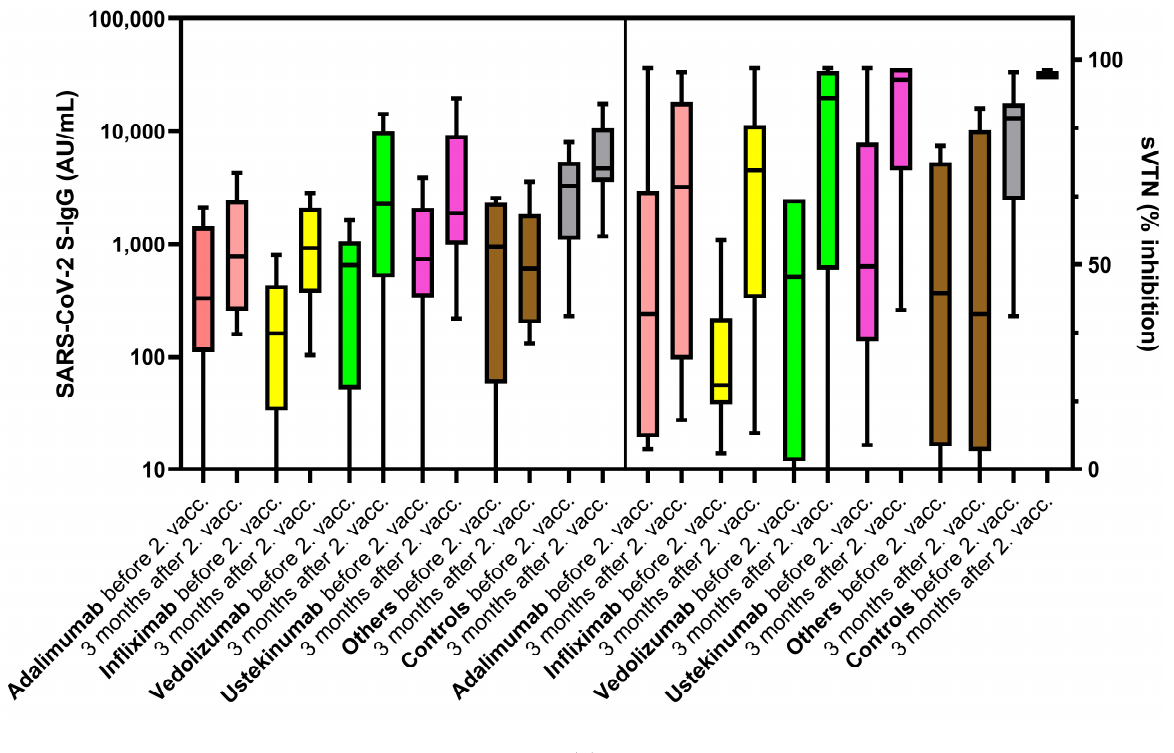
Figure 2. SARS-CoV-2-S IgG and sVTN inhibition levels in IBD patient subgroups before the second vaccination ( a ) and 3 months after the second vaccination ( b ). Comparison of antibody levels between IBD patients on immunosuppressive therapy (anti-TNF, vedolizumab) and healthy controls before the second vaccination ( c ) and 3 months after the second vaccination ( d ), antibody levels of all IBD patients in relation to existing immunosuppressive therapy compared with healthy controls ( e ). Tukey boxplots, * p > 0.05, ** p < 0.01.